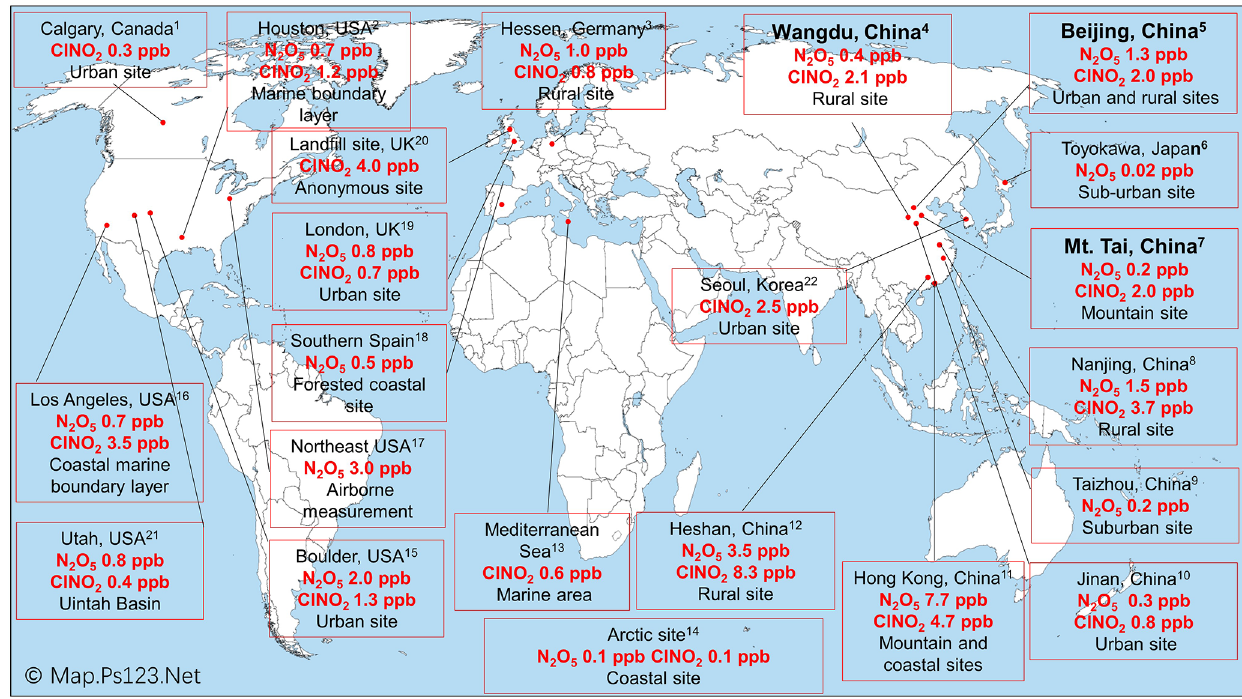
Figure 4. Previous observations of ClNO 2 and N 2 O 5 levels worldwide. Observation sites in this study are shown in bold. The ClNO 2 and N 2 O 5 levels shown are the highest that were measured at these sites. Footnotes associated with the locations refer to the references as